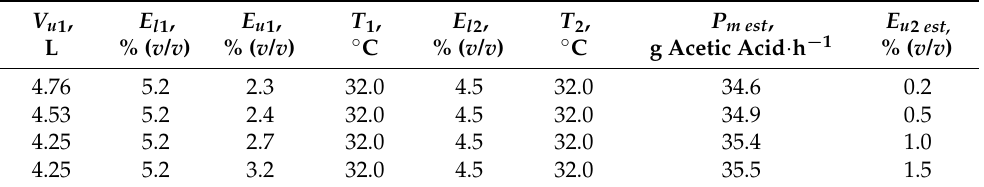
Table 13. Values of the operational variables needed to maximize P m est with an E u 2 est value of 0.2%, 0.5%, 1.0% or 1.5% ( v / v